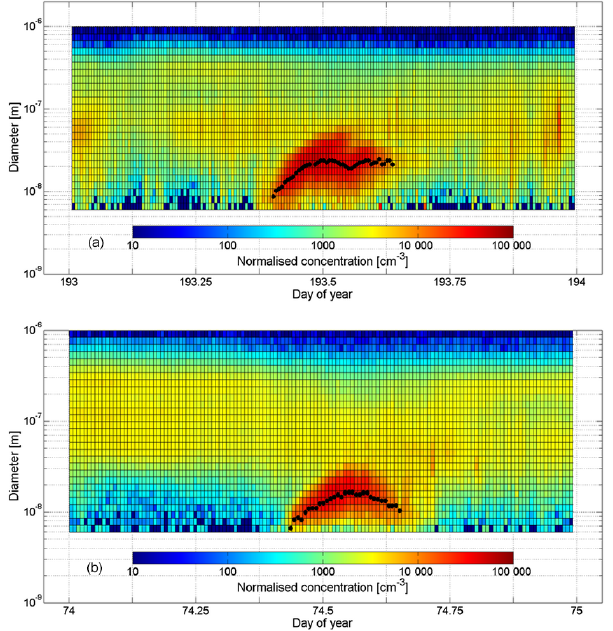
Figure 10. Size distribution surface plots for NPF and consecutive particle growth as banana-shaped plot limited in time (a) in the city centre on Tuesday, 12 July 2012, and as arch-shaped plot (b) in the city centre on Friday, 15 March 2013. Time series of the fitted particle number median mobility diameter for the nucleation mode are indicated by black dots on each panel.